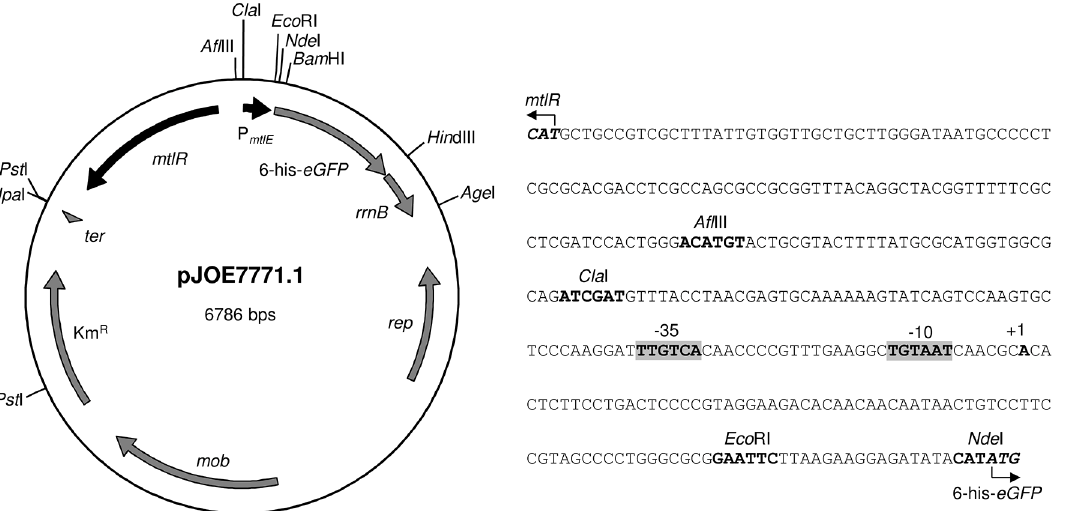
Fig 2. Physical map of pJOE7771.1, a pBBR1MCS-2 derivative with low copy number, and nucleotide sequence of the mtlR /6-his- eGFP intergenic region. Restriction sites used for the construction of pJOE7771.1, pJH189.1 and the P mtlE mutant plasmids pJH210.1-pJH258.1 are shown. Mannitol, arabitol, or glucitol-inducible expression of the reporter gene eGFP is mediated by P mtlE and mtlR . The -10 and -35 boxes of P mtlE are indicated in the nucleotide sequence. The transcription start site of P mtlE was determined by a modified 5 ’ -RACE protocol (see materials and methods).